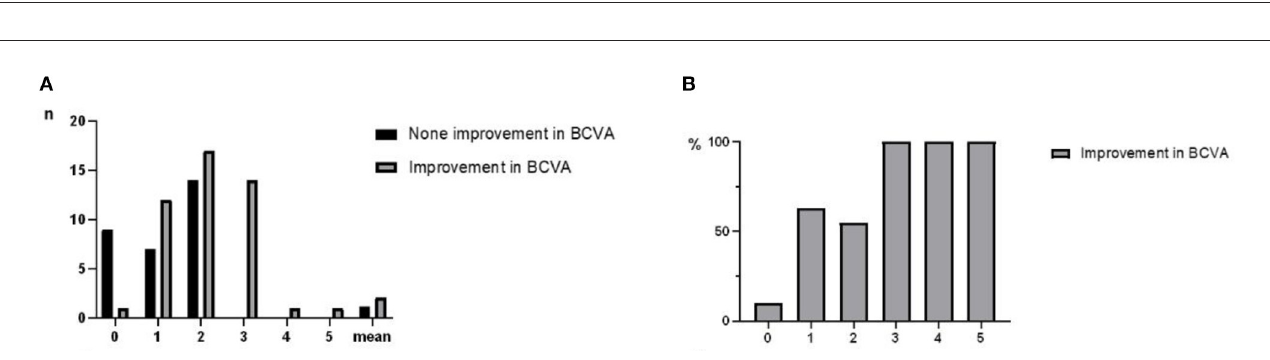
FIGURE4 (A) Times of dressing change in TON patients after surgery: The average time of dressing change in the improved group was 2.11 times, and that in the non-improved group was 1.17 times. (B) Times of dressing change were significantly correlated with prognosis (*** P < 0.001).